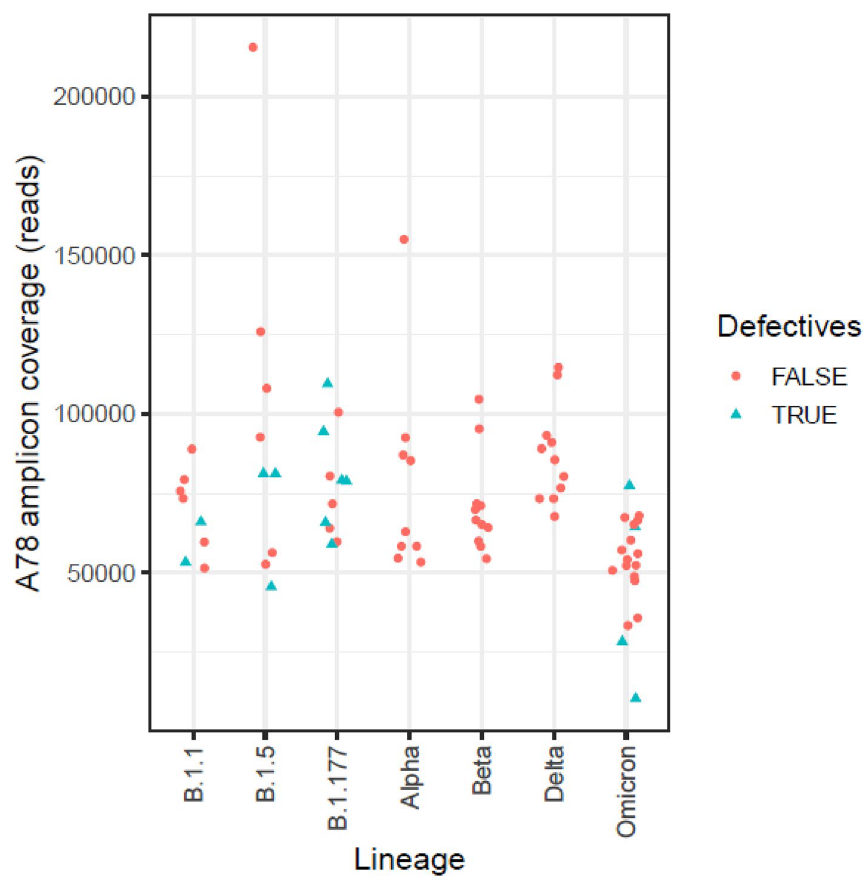
Figure 1. Amplicon A78 (nt 1905 to 2260, aa636-aa753) coverage per variant. Red dots represent reads with no defective haplotypes detected in amplicon A78 and blue triangles indicate reads with defective haplotypes in this